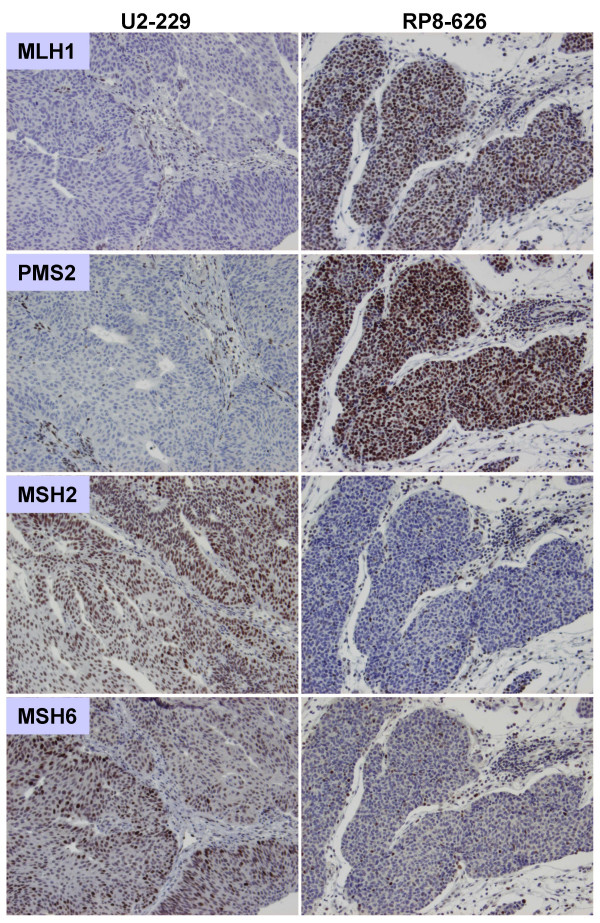
Immunohistochemical staining for the MMR proteins shows loss of nuclear expression for MLH1 and PMS2 and retained expression of MSH2 and MSH6 in case U2-229, and loss of MSH2 and MSH6 with retained expression of MLH1 and PMS2 in case RP8-626.